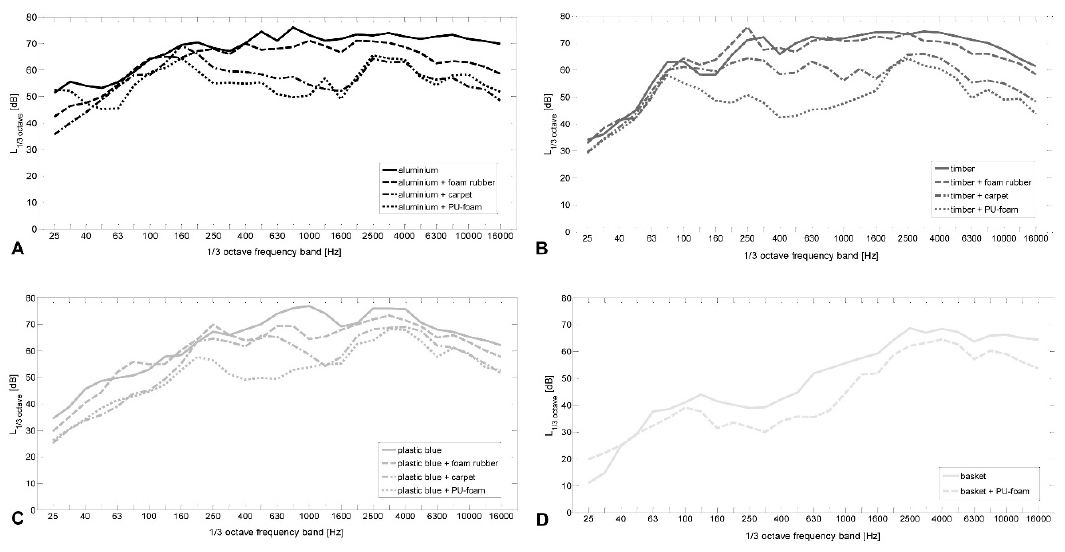
Figure 5. Band-filtered LEGO Duplo toy brick dropping noise spectra measured in different storage cases. ( A ) “aluminium”; ( B ) ”timber”; ( C ) “plastic blue”; and ( D ) “basket”. Impact of different insert damping materials (foam rubber, carpet, PU foam).